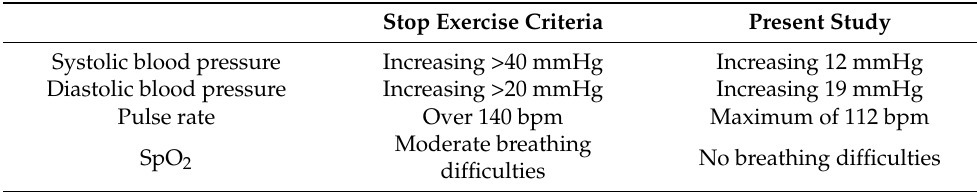
Table 5. Stop exercise criteria in this study. Stop Exercise Criteria Present Study Systolic blood pressure Increasing >40 mmHg Diastolic blood pressure Pulse rate Over 140 bpm Maximum of 112 bpm Moderate breathing SpO 2 No breathing difficulties difficulties The criteria were set according to the guidelines for safety management and promotion in rehabilitation medicine, proposed by the Japanese Association of Rehabilitation Medicine